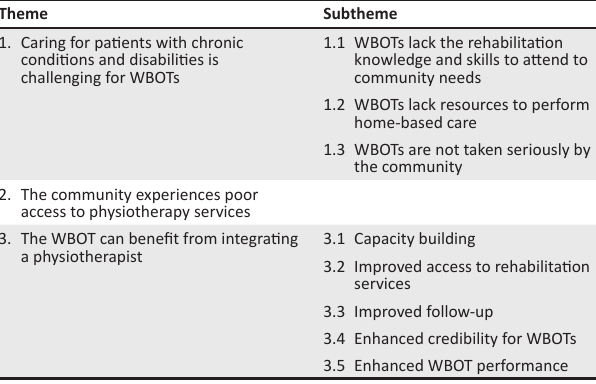
TABLE 2: Themes and